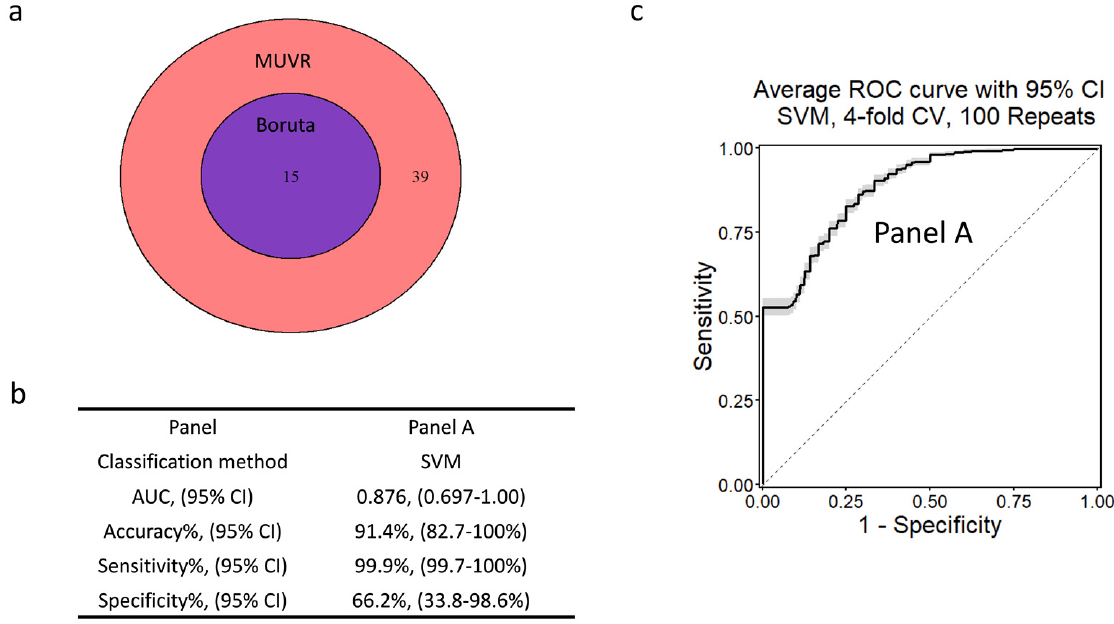
Figure 3. Machine learning outcome. ( a ) A Venn diagram of the overlapping proteins between MUVR and Boruta, feature selection algorithms. ( b ) The performance characteristics of the best classification method (SVM). ( c ) An ROC curve of Panel A’s SVM outcome showing the trade-off between true positive rate (sensitivity) and false positive rate (1 – specificity) for different classification thresholds. Table 2. MUVR and Boruta overlapping proteins, Panel A, that best discriminative between ASD and HCs.